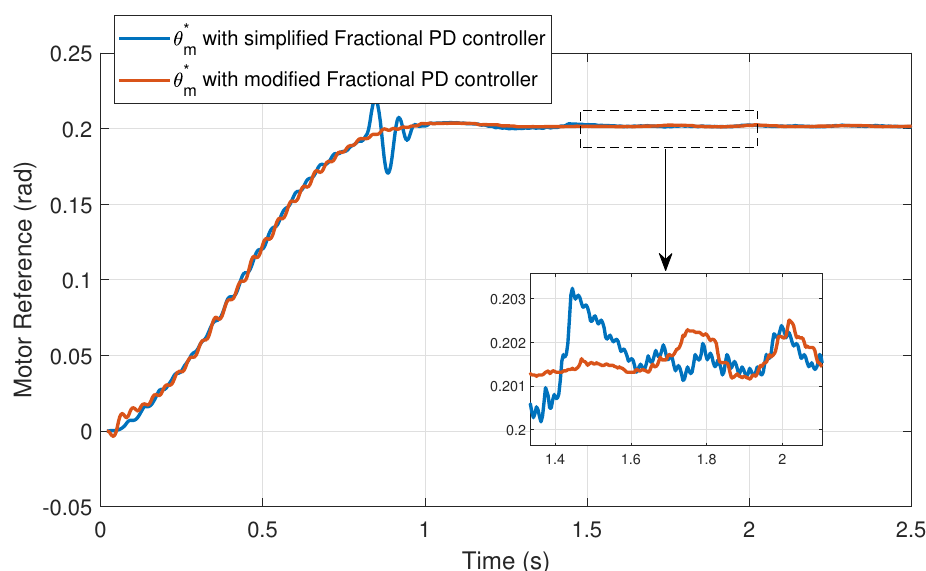
Figure 17. Experimental motor reference angles θ ∗ m ( t ) using the two FPD